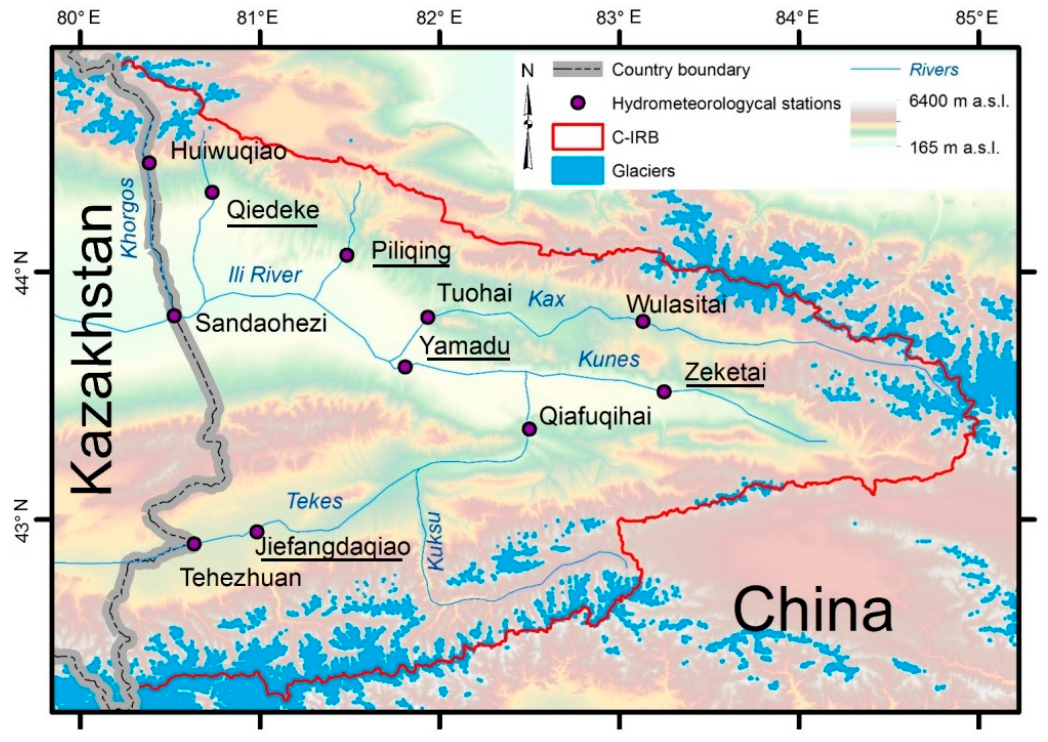
Figure 1. Study area. Stations used for trend analysis are underlined.